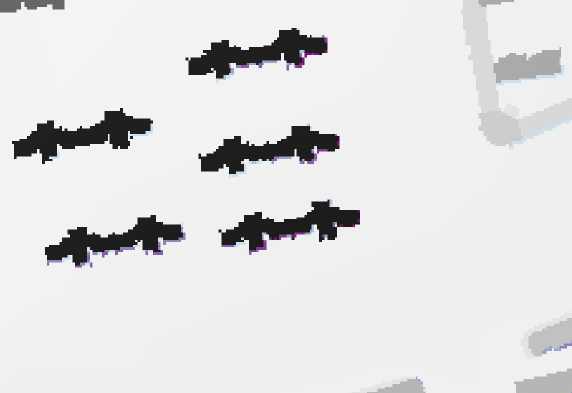
Figure 11 . The high-rise buildings near the core area of the old town have purple and blue lines on the edge, meaning it has a great impact on the town’s visual